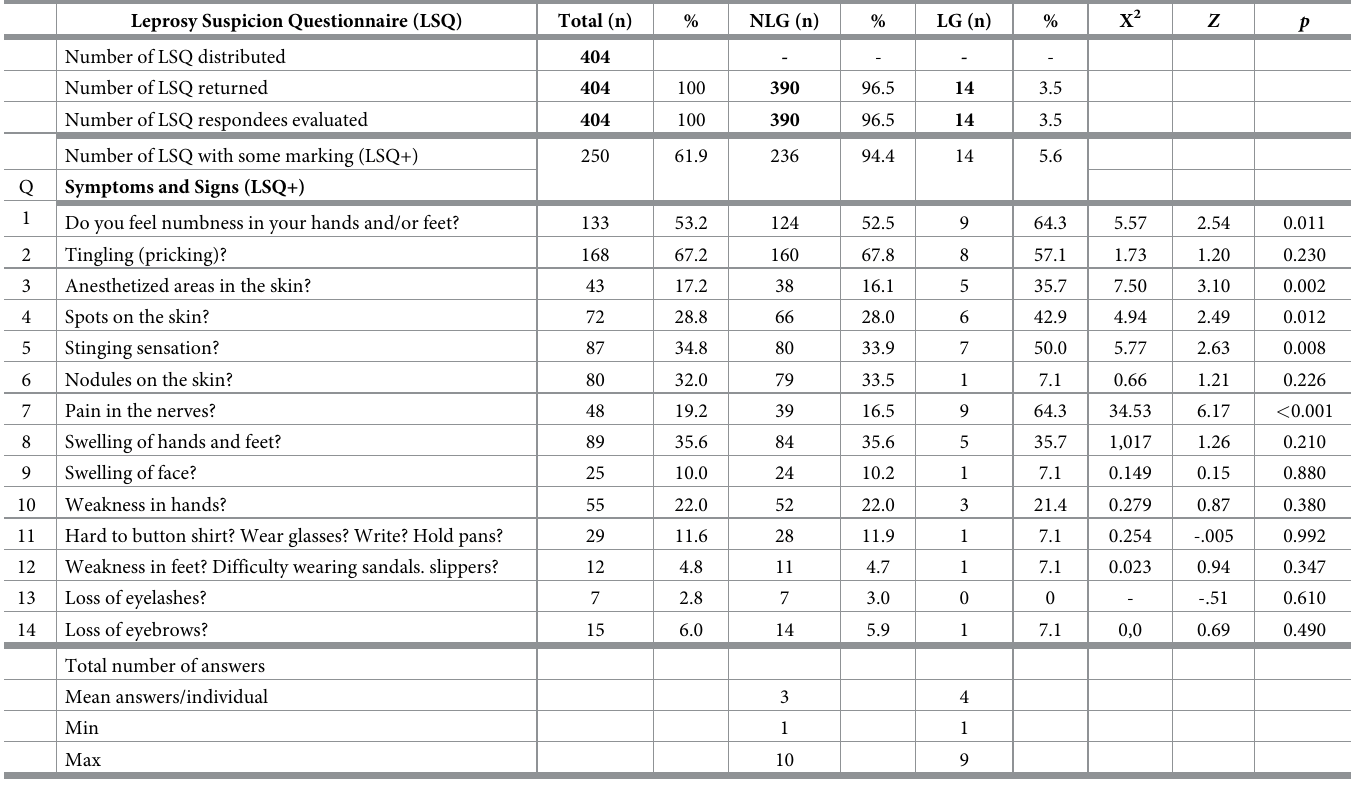
Table 1. Number of individuals ranked according to total signs and symptoms of leprosy marked on the LSQ in order of frequency (n = 250). Leprosy Suspicion Questionnaire (LSQ)